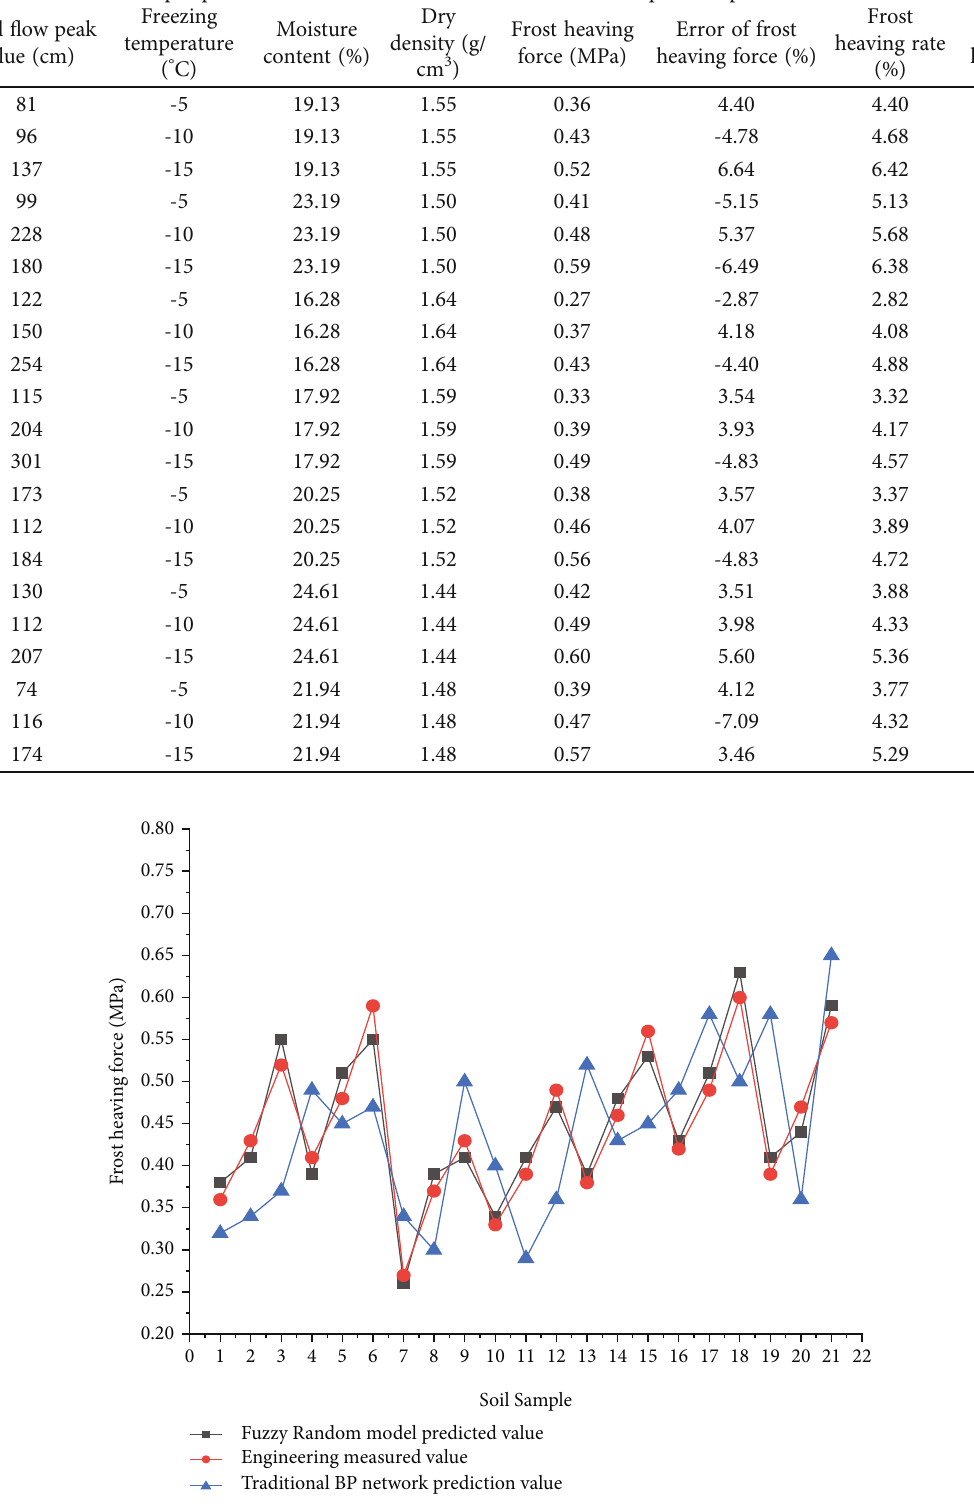
Figure 8: Comparison of fuzzy random model predicted and measured values of frost heaving